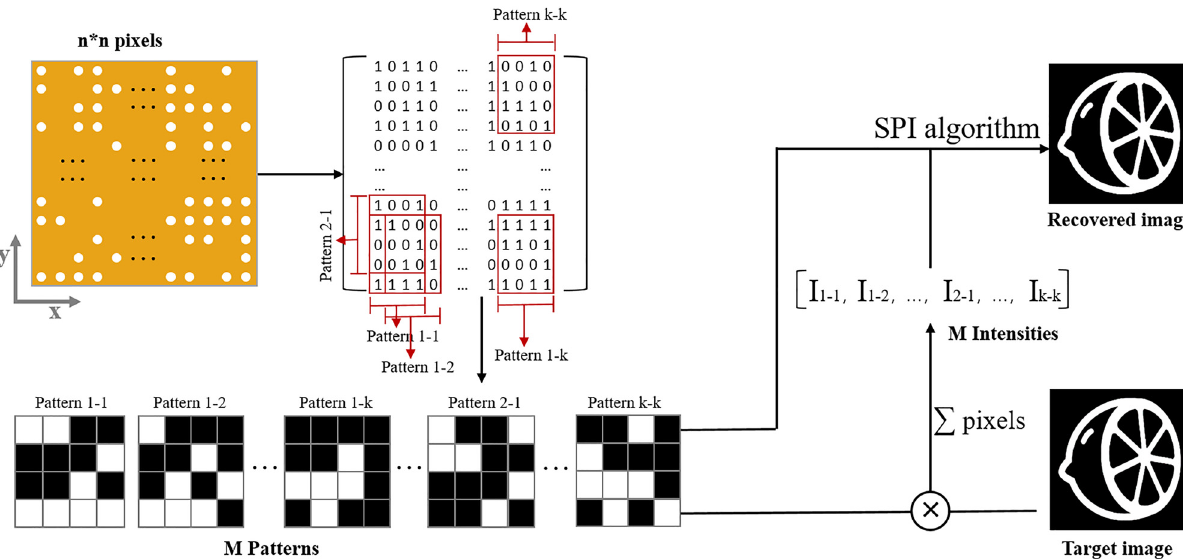
Figure 3: The flow chart of SPI algorithm. The metasurface is composed of various multiplexed patterns through spatial shift. The red square boxes represent the matrix form of the corresponding position of the metasurface and its corresponding patterns are given below. Those patterns can function as the amplitude mask to the object, whose transmit intensity is measured to recover the whole image through SPI